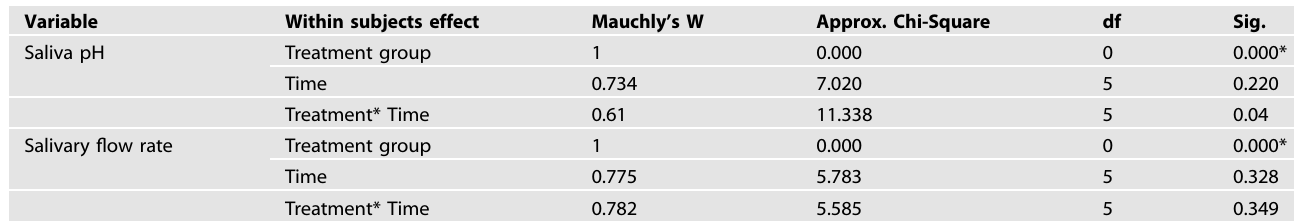
Fig. 3 The change of salivary fl ow rate values of groups A and B in the studied time points. (X-axis: T0,T1,T2 and T3; Y-axis: salivary fl ow rate values [ml/min]). Table 4. Mauchly ’ s test of